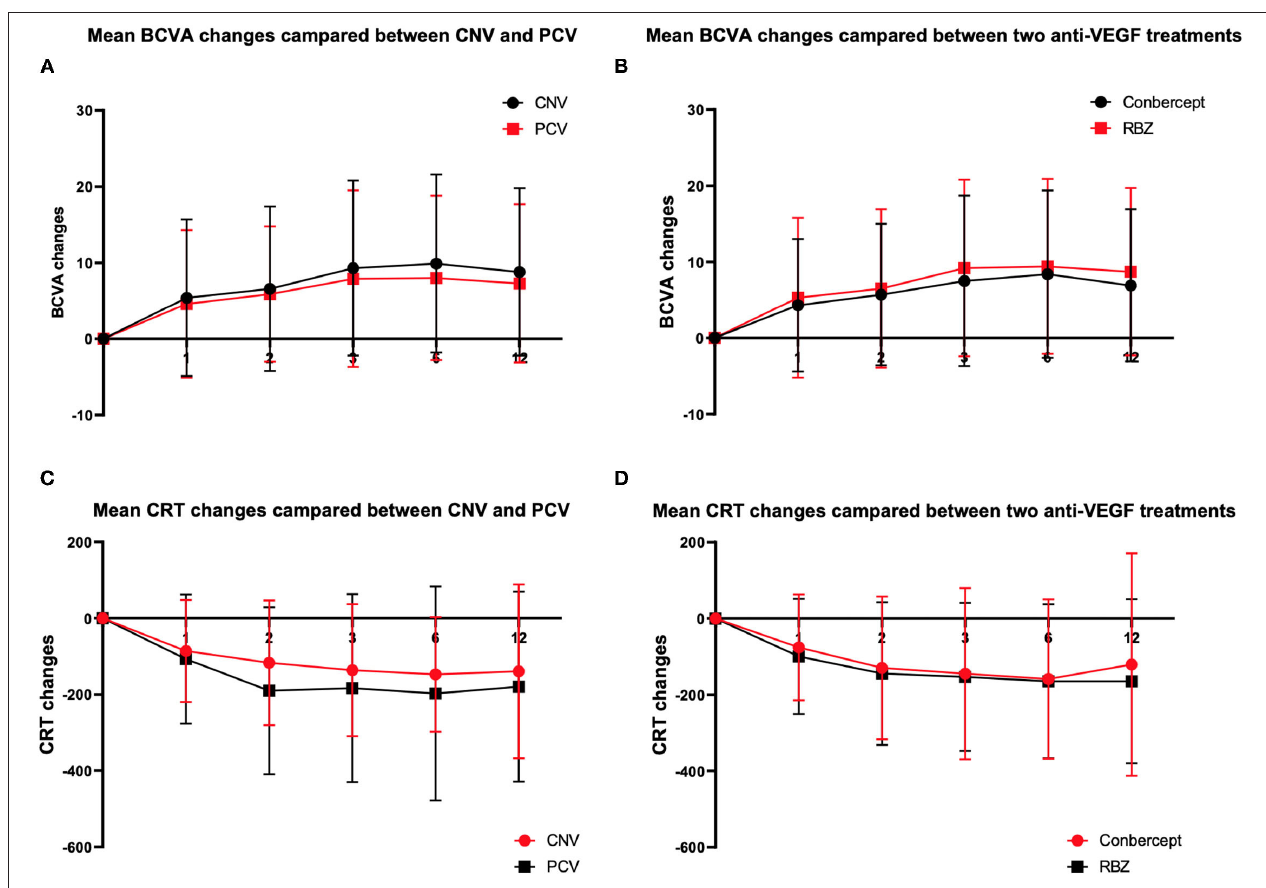
FIGURE 1 | BCVA (A,B) and CRT (C,D) changes from baseline to month 12 in different grouping